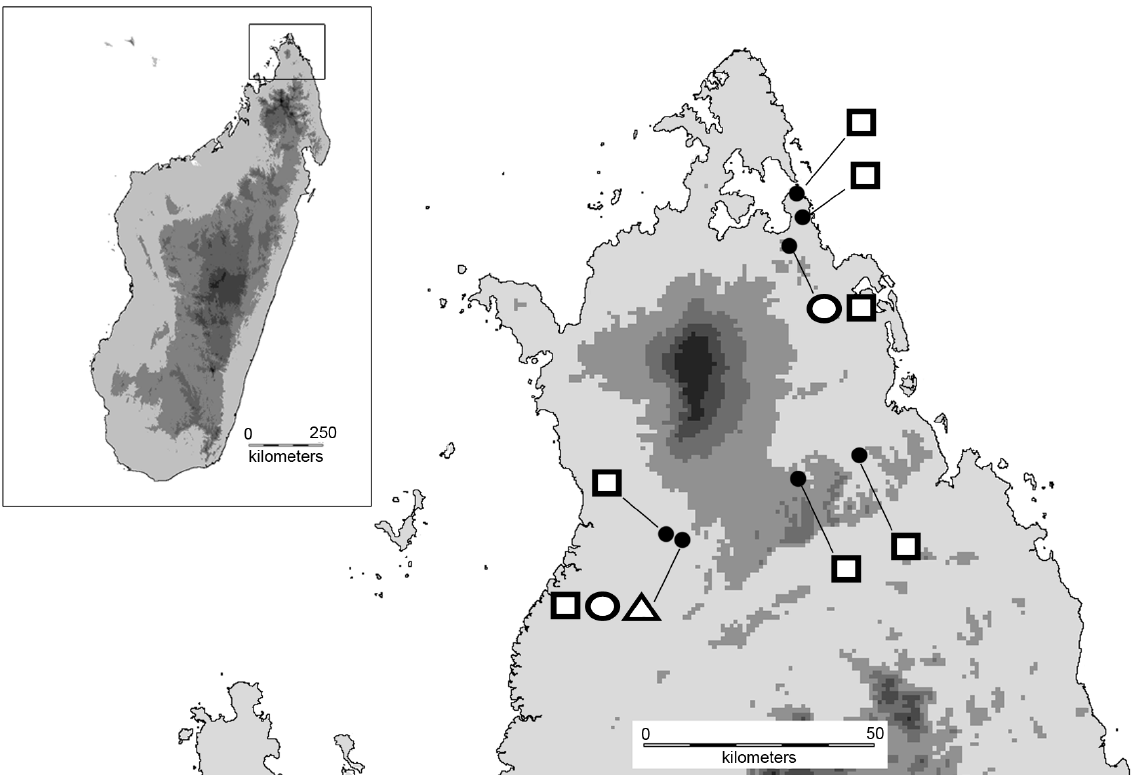
Fig. 4. Distribution map of northern Madagascar showing the seven localities (black circles) where freshwater crabs were collected in the present study: Foza manonae sp. nov. (white circles), F. ambohitra (triangle), and Madagapotamon humberti